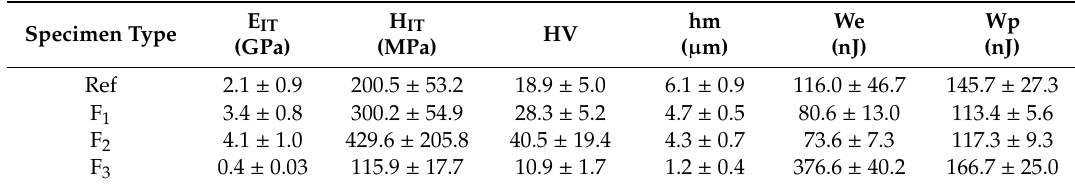
Table 3. Micromechanical properties presented as average and standard deviation ( 𝑋 ± 𝑆𝐷 ) determined in the indentation test for references and irradiated specimens.